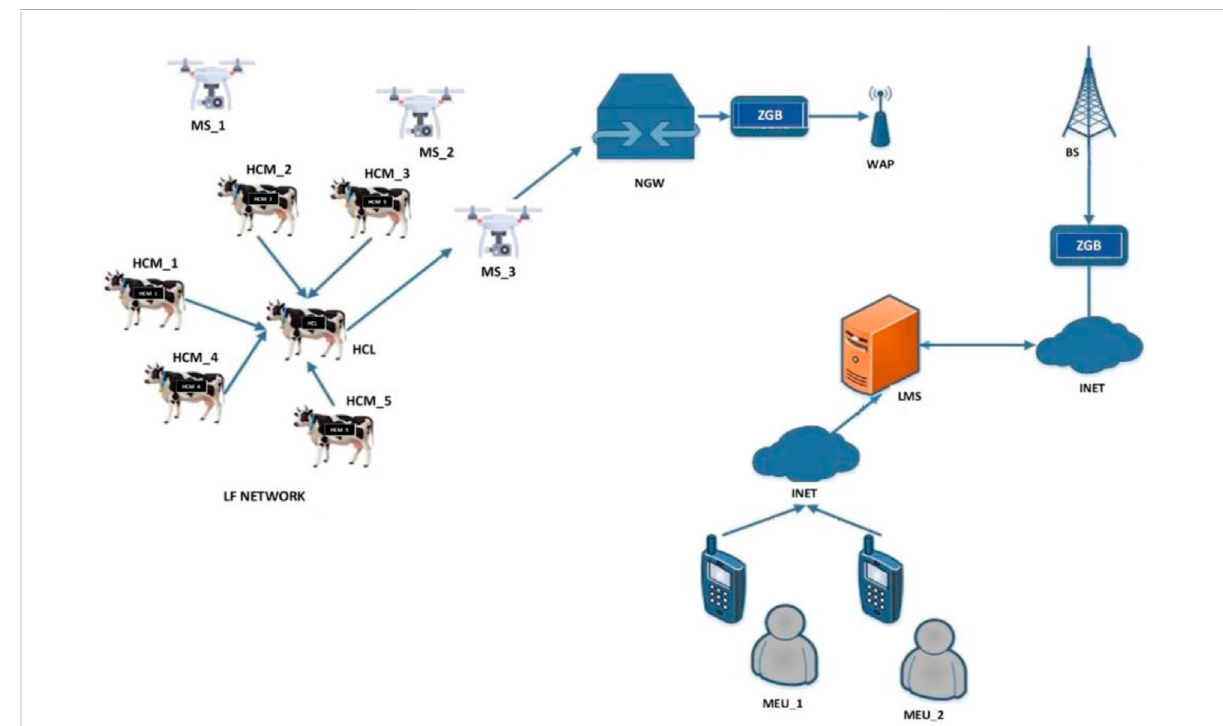
FIGURE 1 Integrated network architecture (Alanezi et al.,